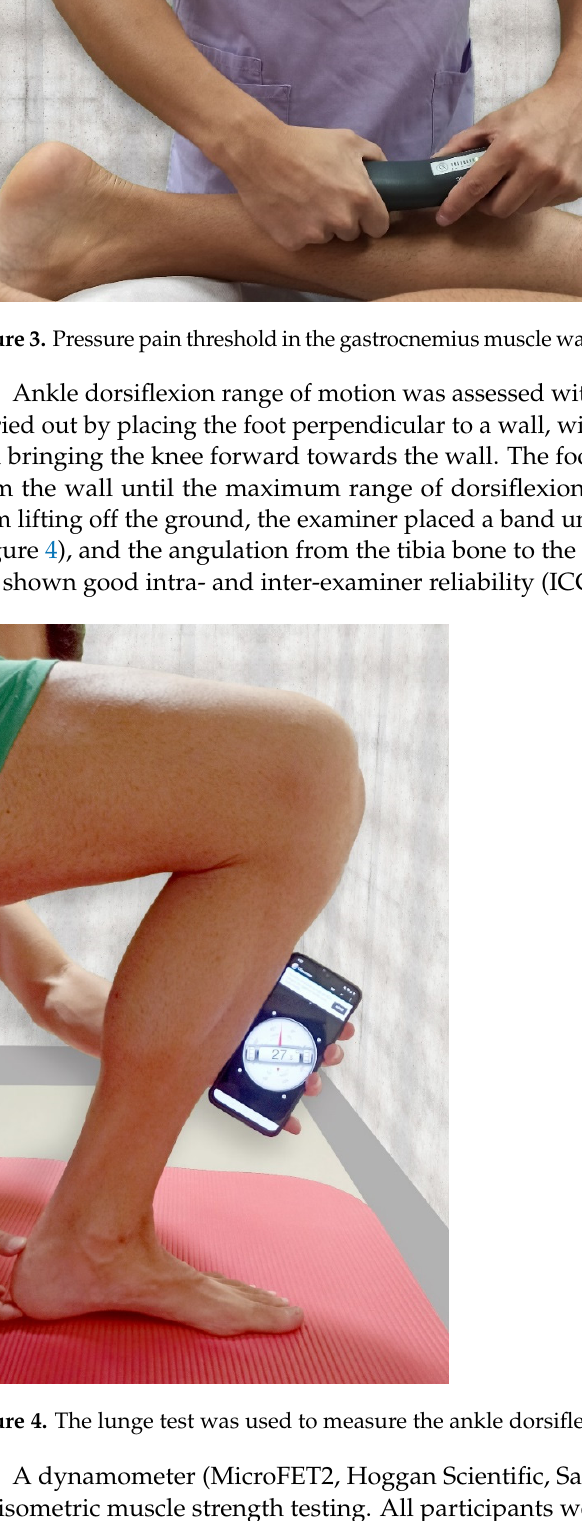
Figure 5. The isometric muscle strength testing with a manual dynamometry. 2.5. Dry Needling Intervention Participants were used as their own controls. One of the lower limbs received the intervention randomly, whereas the other limb acted as a control and did not receive any intervention. Outcomes were evaluated with a 2 min difference between both legs. A single dry needling treatment session was performed on the experimental limb in the latent TrP found during the exploration on the gastrocnemius muscle. If multiple TrPs were found, dry needling was applied on the most painful latent TrP in one gastrocnemius muscle. With participants in a prone position, 0.30 mm × 50 mm disposable stainless-steel needles (3B Scientific, Paterna, Spain) were inserted into the skin over the latent TrP (Figure 6).